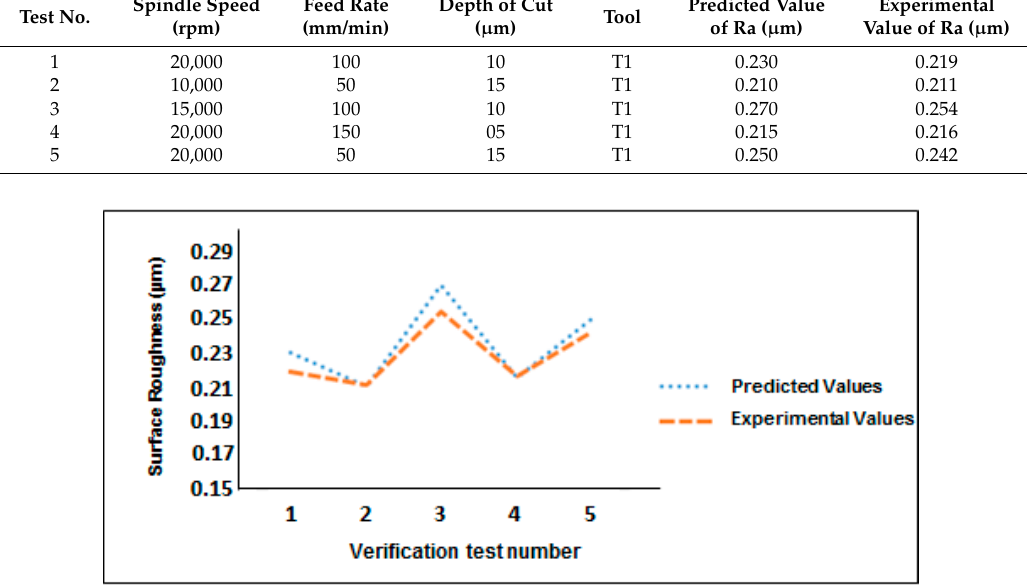
Figure 5. Verification test with random cutting parameters.